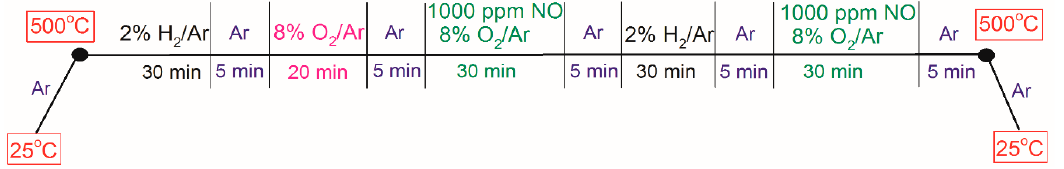
Figure 10. Series of conditions for the degreening procedure carried out for 2 wt. % Pt/Al 2 O 3 catalyst.